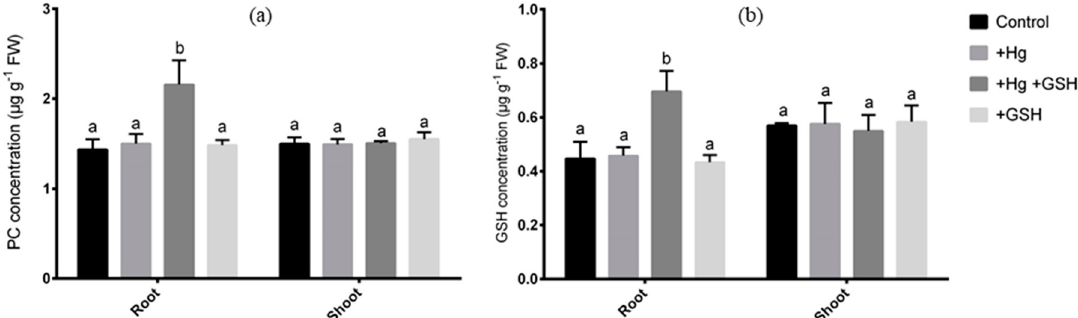
Figure 8. Changes in phytochelatin (PC) and glutathione (GSH) in alfalfa. Concentration of PC ( a ) and GSH ( b ) in the root and shoot of alfalfa cultivated in di ff erent conditions of Hg and GSH: + Hg (40 µ M), + Hg + GSH (40 µ M Hg + 50 µ M GSH), and + GSH (50 µ M GSH). Data represent means ± SD of three independent biological samples. Di ff erent letters indicate a significant di ff erence at the p < 0.05 level.